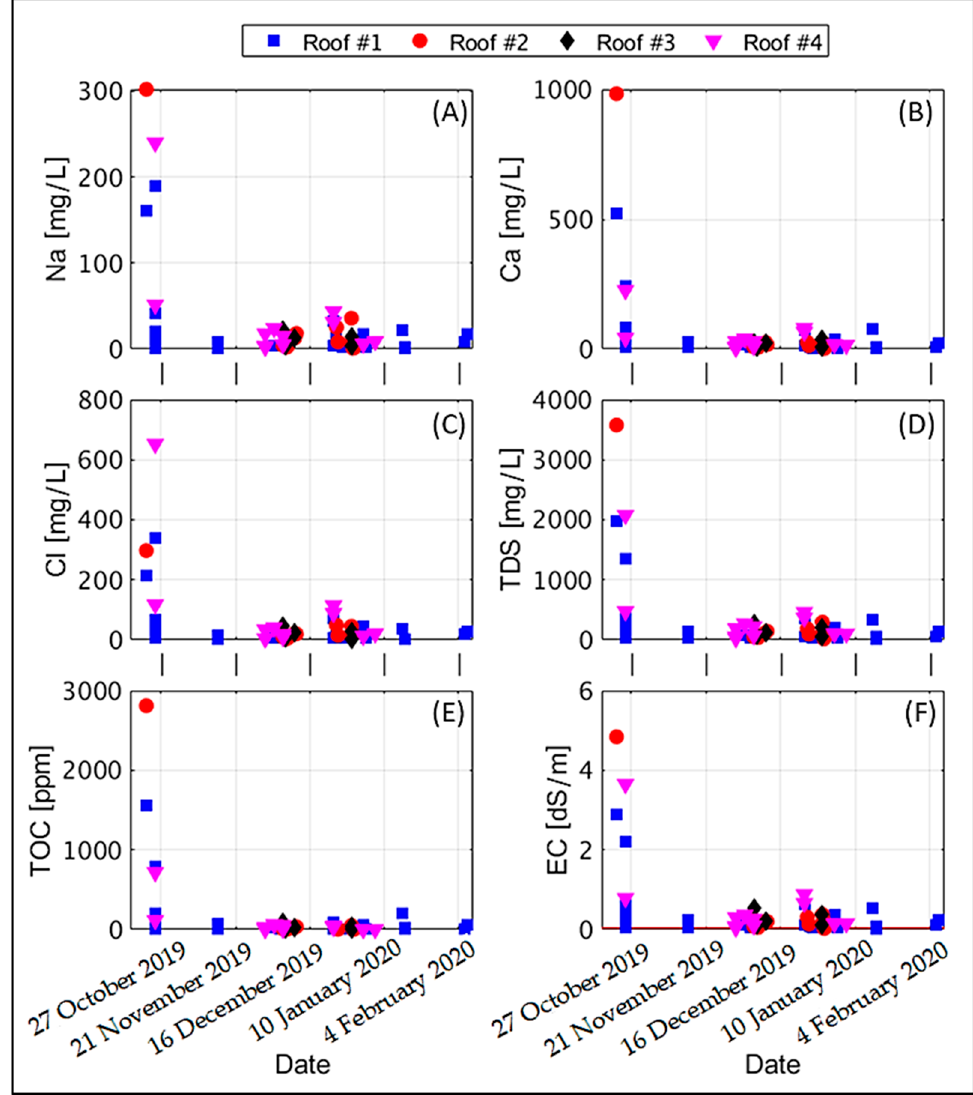
Figure 1. Measured concentrations of sodium ( A ), calcium ( B ), chlorine ( C ), TDS ( D ), TOC ( E ), and the electric conductivity ( F ) of the sampled water from the examined four roofs. The red line in ( F ) marks the measured EC of the rainwater sample (~0.04 dS/m). Each data point is of a single sample.